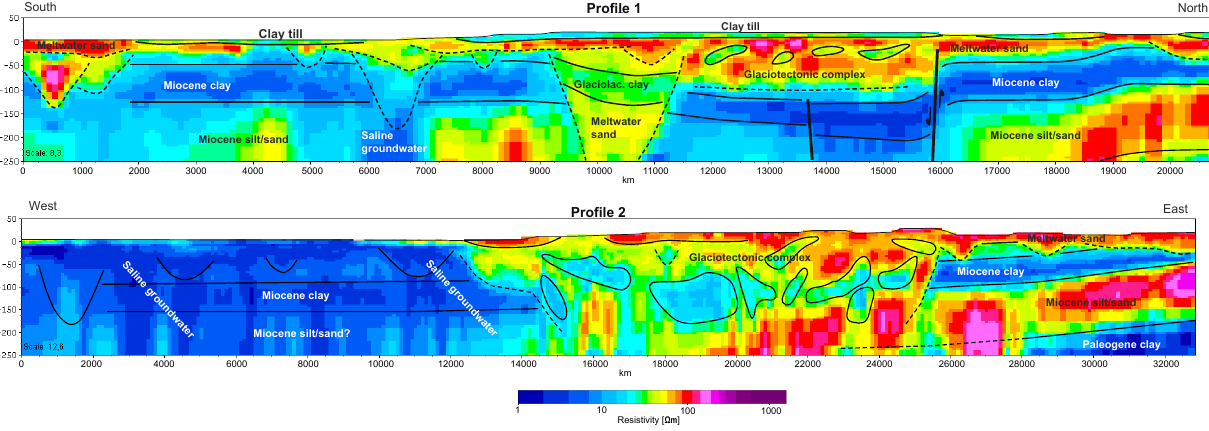
Fig. 11. Cross section profiles through the SkyTEM 3-D resistivity grid: for location, see Figs. 5, 9 and 10. The deep valley seen in the seismic data on Figs. 6 and 7 is clearly seen on profile 1 (coordinate 10000m) where the Miocene clay is interrupted. The Tønder Graben structure is evident in the northern part of the profile. The area is partly capped by a thin sheet of clay till. Profile 2 shows the increased salinity in the western part, the dipping Miocene clay and one of the two glaciotectonically deformed areas. Vertical exaggeration 8 and 12 ×